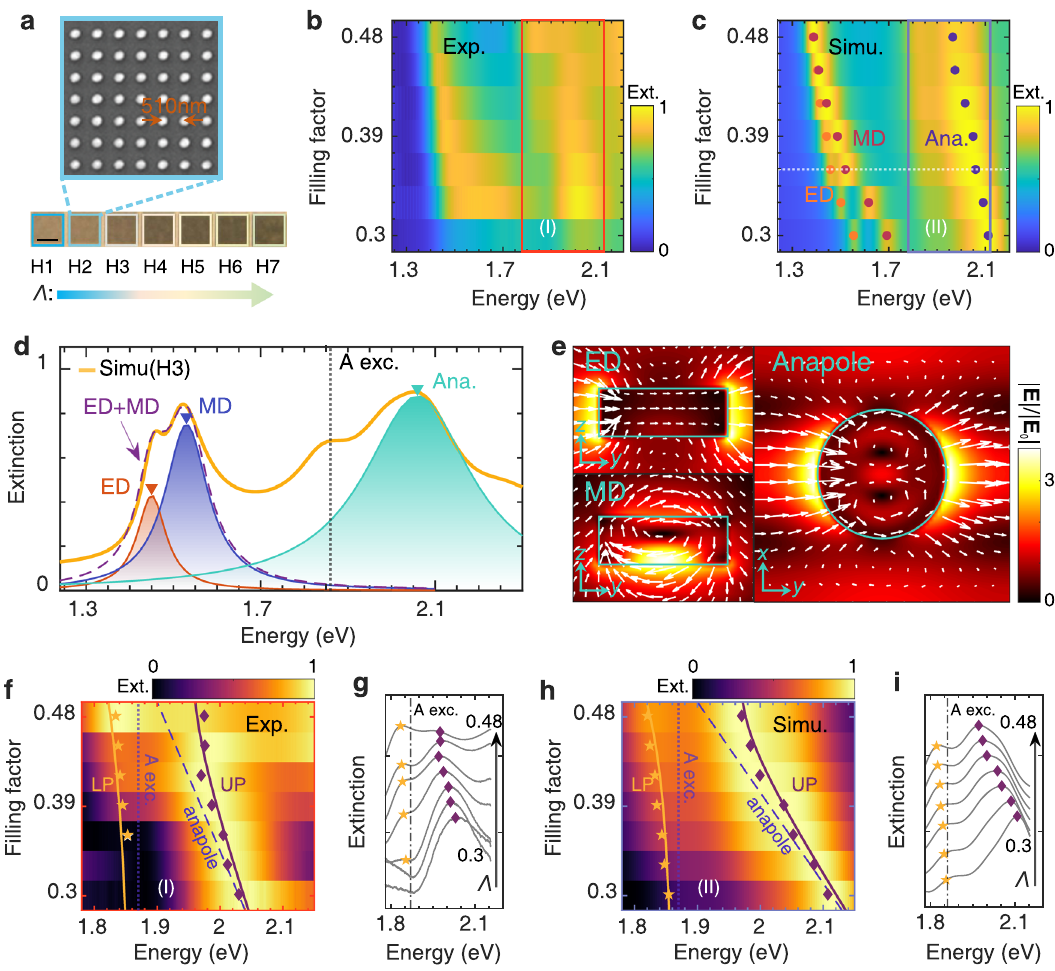
Fig. 5 | Mie resonant modes and exciton-anapole polaritons in 2D MoS 2 disk arrays. a Optical microscope images of 2D MoS 2 disk arrays (H1-H7, i.e., P =510nm and Λ is from 0.3 to 0.48), along with the SEM image for H2 sample. The scale bar represents 20 μ m. b, c Measured ( b ) and simulated ( c ) extinction spectra (under normal incidence) for H1-H7. Red, blue, and cyan circles represent the resonant frequencies of electric dipole (ED), magnetic dipole (MD), and anapole modes. d The simulatedspectrum forH3region (indicatedby the white dottedline in( c )). Red, blue, and cyan lines are Lorentzian fi ttings for ED, MD, and anapole modes. ThepurpledashedlineisthesumoftheEDandMD fi ttingcurves.Theblackdashed